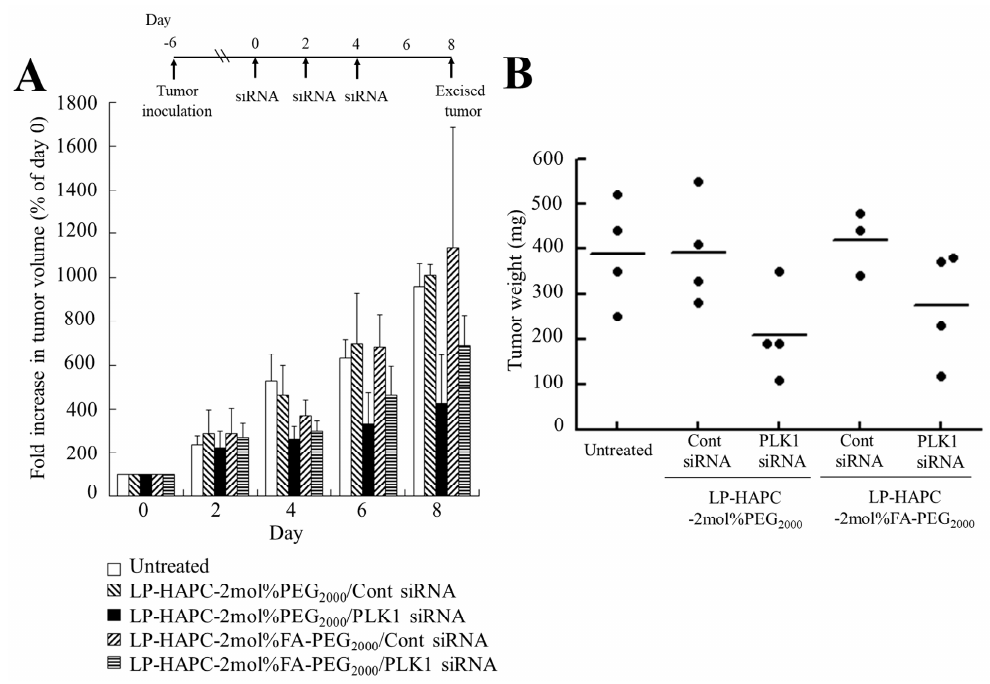
Figure 10. In vivo siRNA therapy of KB tumor xenografts with FA-PEG-modified PLK1 siRNA lipoplexes in mice. When the average volume of the xenograft tumors reached 80 mm 3 (day 0), LP-HAPC-2mol%PEG 2000 and LP-HAPC-2mol%FA-PEG 2000 lipoplexes with 10 µ g of Cont siRNA or PLK1 siRNA were injected directly into the tumor three times (day 0, 2, and 4). Tumor volume was measured at days 0, 2, 4, 6, and 8 ( A ). Tumor volume (%) was calculated as relative to each tumor volume at the day 0. The mice were sacrificed at day 8, and then the excised tumors were weighed ( B ). Each result represents the mean + SD ( n = 3–4).